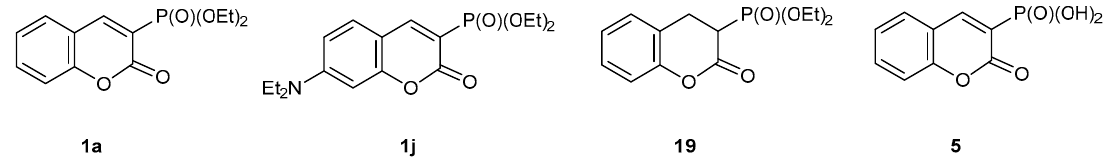
Figure 5. Structures of phosphorus-containing coumarins that were object of theoretical investigations.